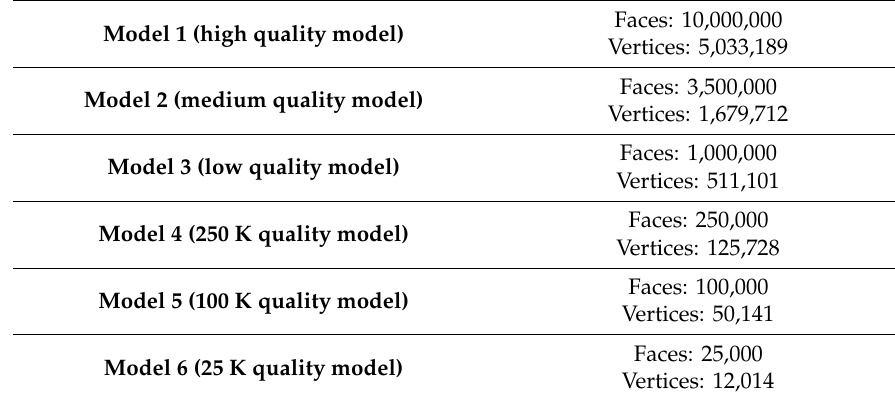
Table 4. Main characteristics of the 3D